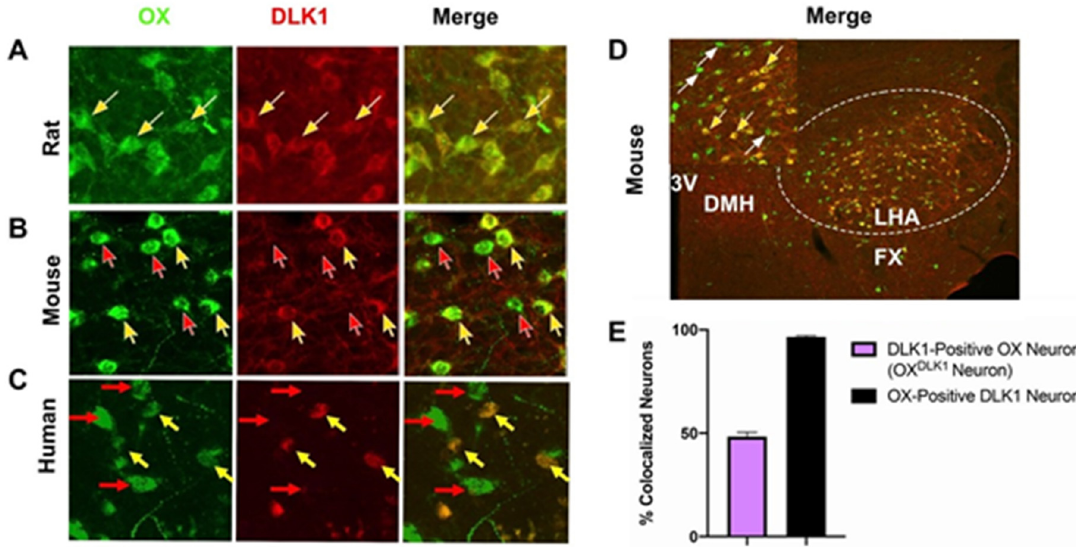
Figure 1. OX (orexin) and DLK1 (delta-like homolog 1) distribution in the LHA (lateral hypothalamic area) di ff ers between species. ( A ) Immunofluorescence for OX (red) and DLK1 (green) in the LHA of rats ( n = 3), ( B ) mice ( n = 8), and ( C ) humans ( n = 3). Yellow arrows identify representative neurons with co-localized OX and DLK1. Red arrows identify neurons with OX immunoreactivity, but not DLK1. OX and DLK1 completely co-localize within the rat LHA, whereas DLK1 is found in approximately half of all OX neurons in the LHA of mice and humans. ( D ) Distribution of OX and DLK1 neurons within the mouse LHA. Neurons with co-expressed OX and DLK1 (yellow arrows) are distributed throughout the region alongside neurons that only contain OX (white arrows). 3V = 3rd ventricle; DMH = dorsomedial hypothalamus; FX = fornix. ( E ) Percentage of OX and DLK1-co-localized neurons in the LHA of mice. Approximately half of all OX neurons are also DLK1 positive (OX DLK1 ) but essentially all DLK1 neurons are OX-positive ( n =